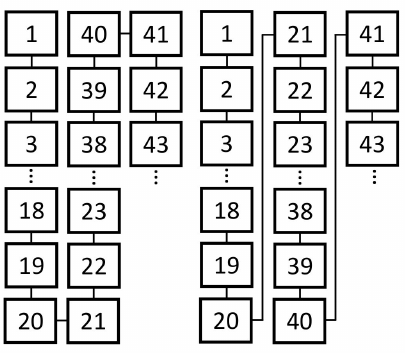
Figure 11. C-type ( left ) and Z-type ( right ) winding layout.